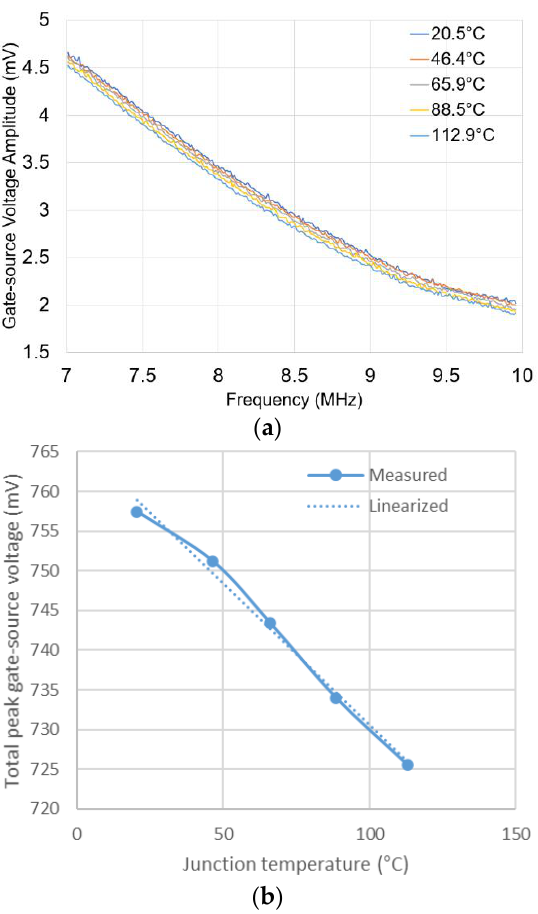
Figure 5. Applying a chirp frequency between 7 and 10 MHz to a 300V biased SiC MOSFET. ( a ) Gate-source voltage amplitude; ( b ) total peak gate-source voltage.